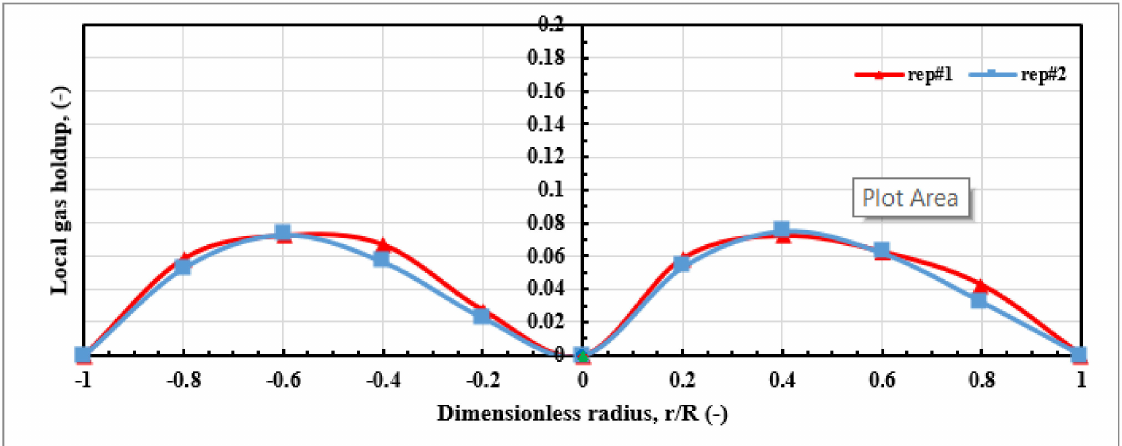
Figure 7. Gas holdup reproducibility in radial profiles of a cylindrical split reactor at middle section and at 3 cm/s gas